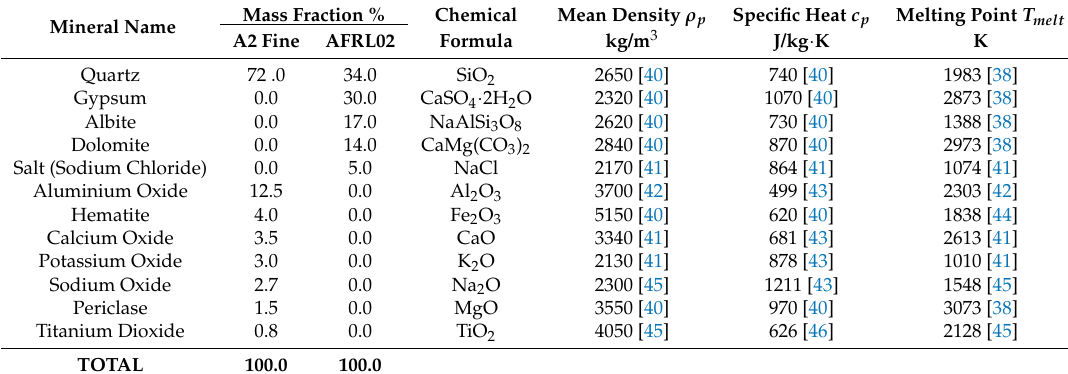
Table 2. Relative proportion of minerals in each test dust and their approximate physical and chemical properties. Where ranges are given, a mid-range value is used. Gypsum and dolomite decompose under heating to form CaO and/or MgO before melting; final melting points of decomposed material are given here